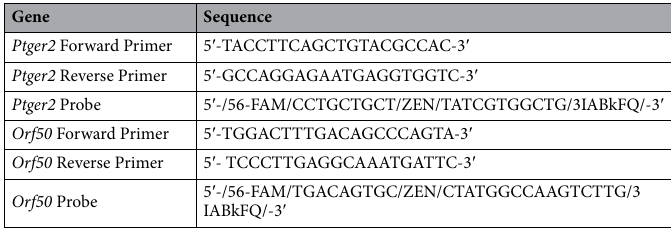
Table 2. γHV68 qPCR primers and probe sequences.